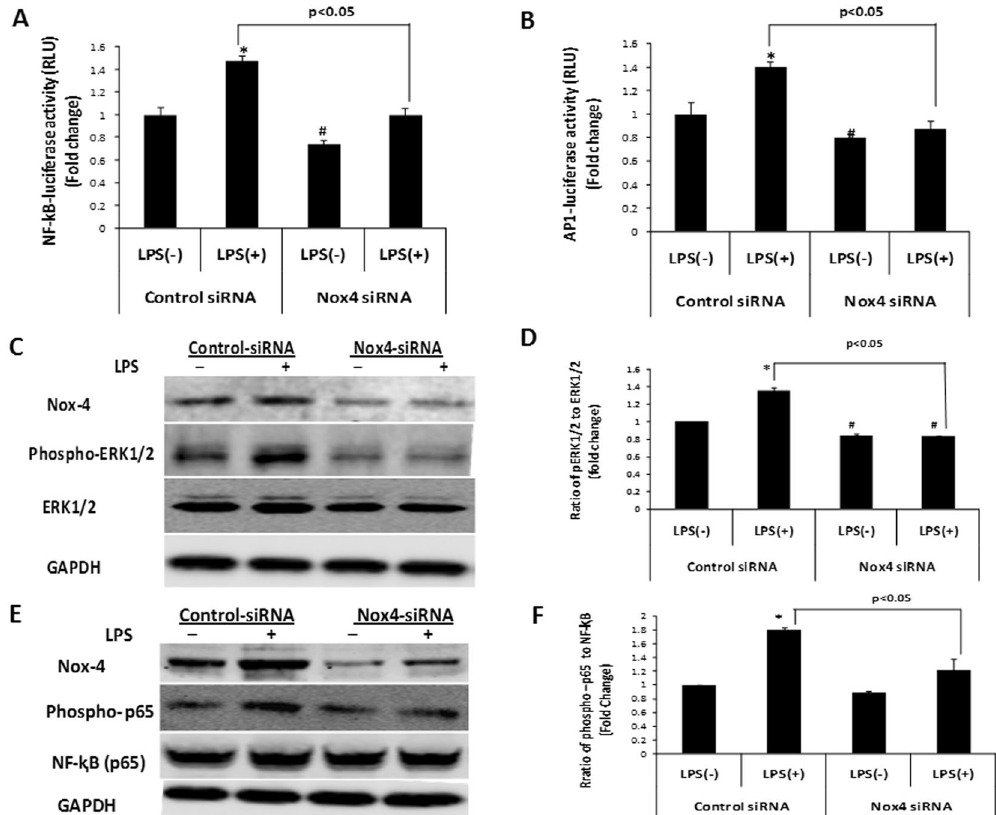
Figure 5. Nox4 downregulation suppressed the LPS induced NF-ĸB and ERK1/2 mediated AP1 activation. ( A , B ) Huh7 cells were either transfected with control or Nox4 siRNA. Then, after 24 hrs, cells were transfected with either NF-ĸB-dependent luciferase or AP1-dependent luciferase reporter construct and after 24 hrscells wereeither treated with PBS or LPS for an additional 6 hrs. Luciferase activity was determined by luciferase reporter assay as described in materials and methods. ( C – F ) Huh7 cells transfected with control or Nox4 siRNA for 48 hrs, and either treated with LPS or PBS for additional 6 hrs. Nox4, phospho-ERK1/2, ERK1/2, phospho- NF-ĸB p65 and NF-ĸB p65 protein levels were analyzed by western blotting. Representative data of three independent experiments (n = 3) are shown. Relative ratios of p-ERK1/2 to ERK1/2 ( D ) and p-NF-ĸB to NF-ĸB ( F ) were quantified by densitometry and normalized by the level of GAPDH. * indicates statistically significant difference from the corresponding controls (p < 0.05). # indicates statistically significant difference from control siRNA LPS ( − ) (p < 0.05). Lines with p values also indicate statistically significance (p < 0.05) between the